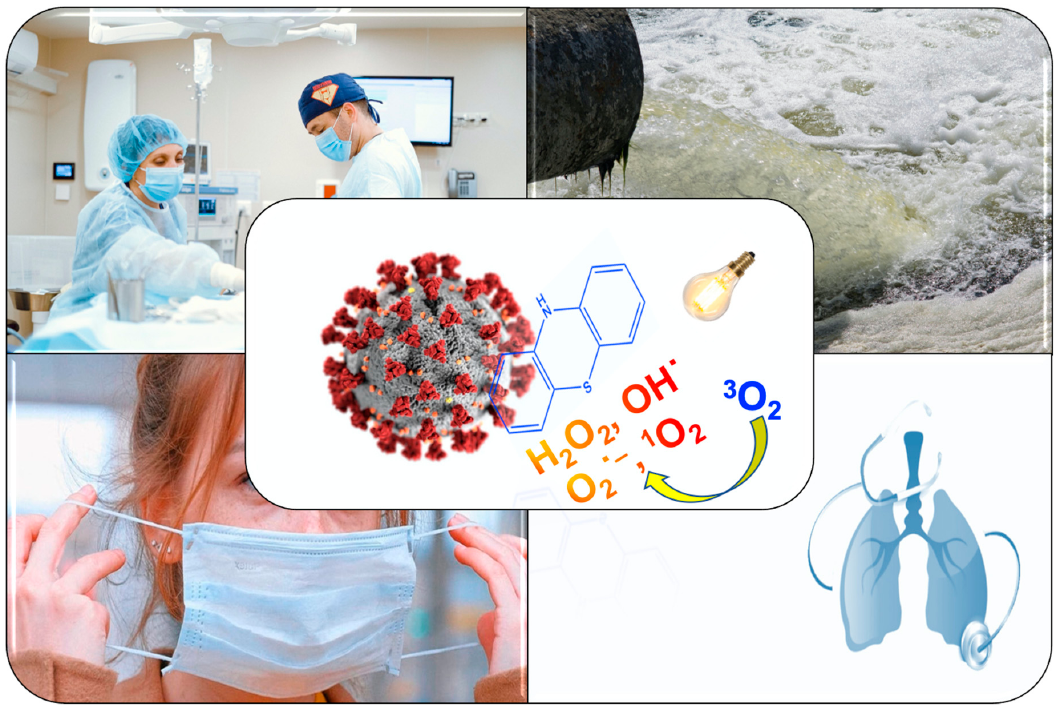
Figure 1. Potential applications of antimicrobial PhotoDynamic Therapy (aPDT) against the severe acute respiratory syndrome coronavirus 2 (SARS-CoV-2) in di ff erent